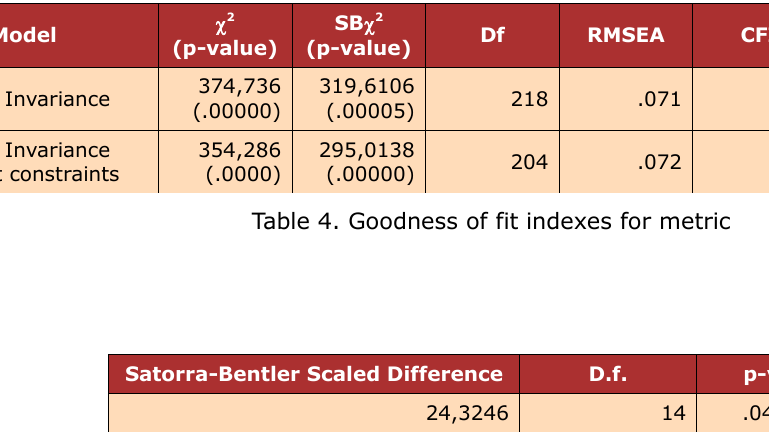
Table 5. Difference of adjusted Satorra-Bentler Chi Squared